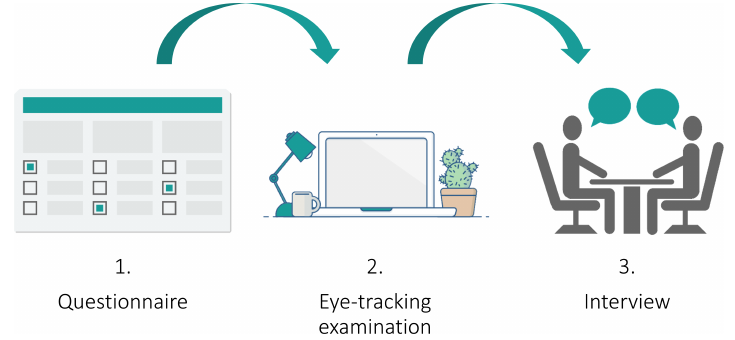
Figure 18. Examination